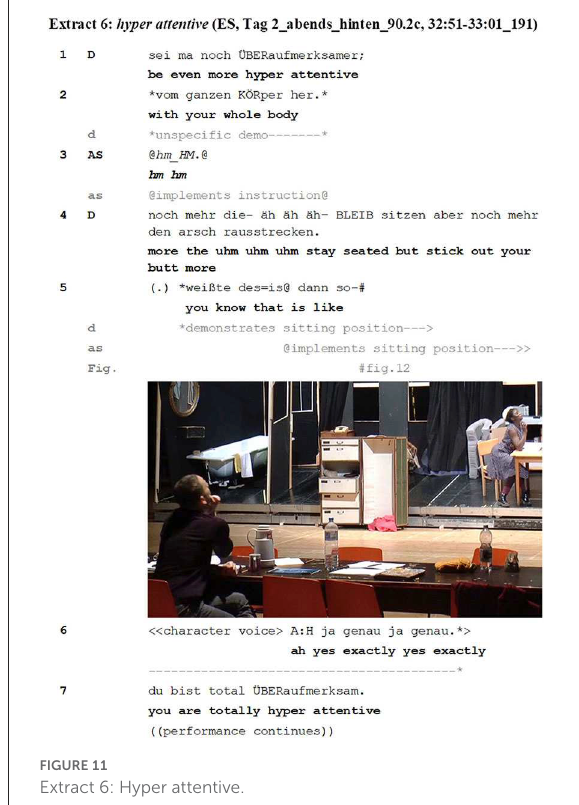
FIGURE11 Extract 6: Hyper attentive.